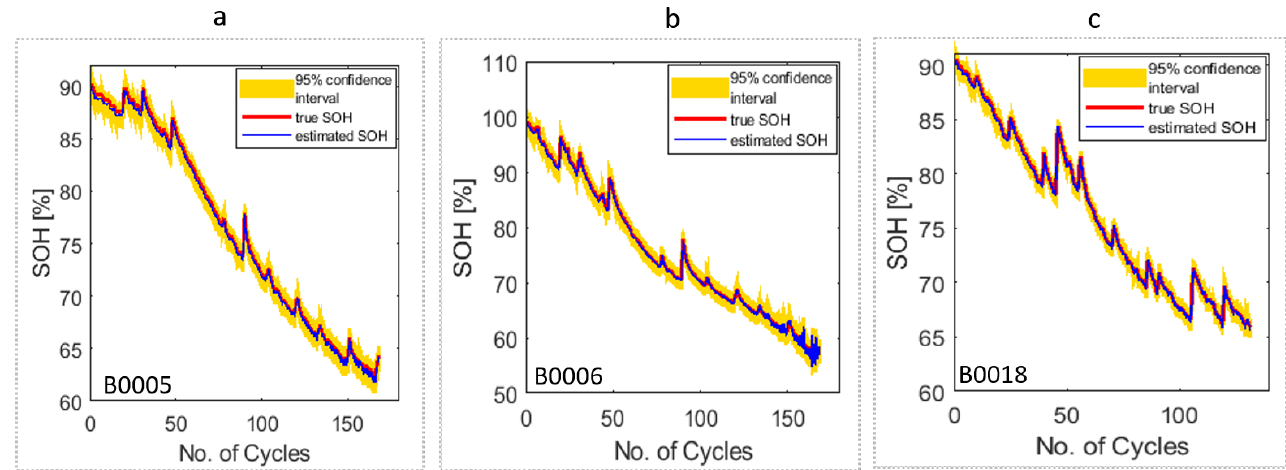
Figure 7. PL-ELM model validation: ( a – c ) model validated with B0005, B0006, and B0018 dataset,